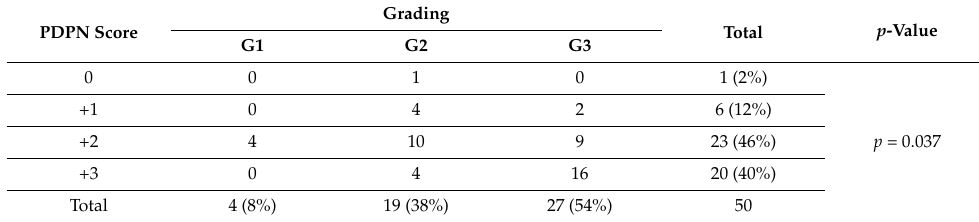
Table 1. Podoplanin score expression in correlation with Broder histological criteria. PDPN